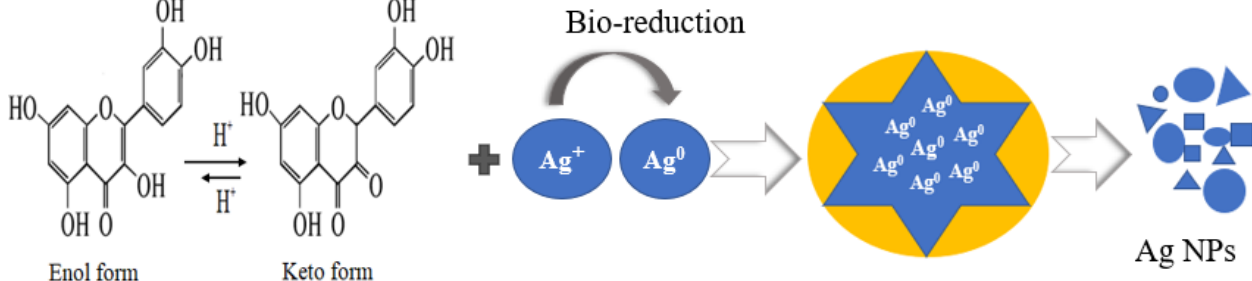
Figure 7. Proposed mechanism for the synthesis of Ag NPs.